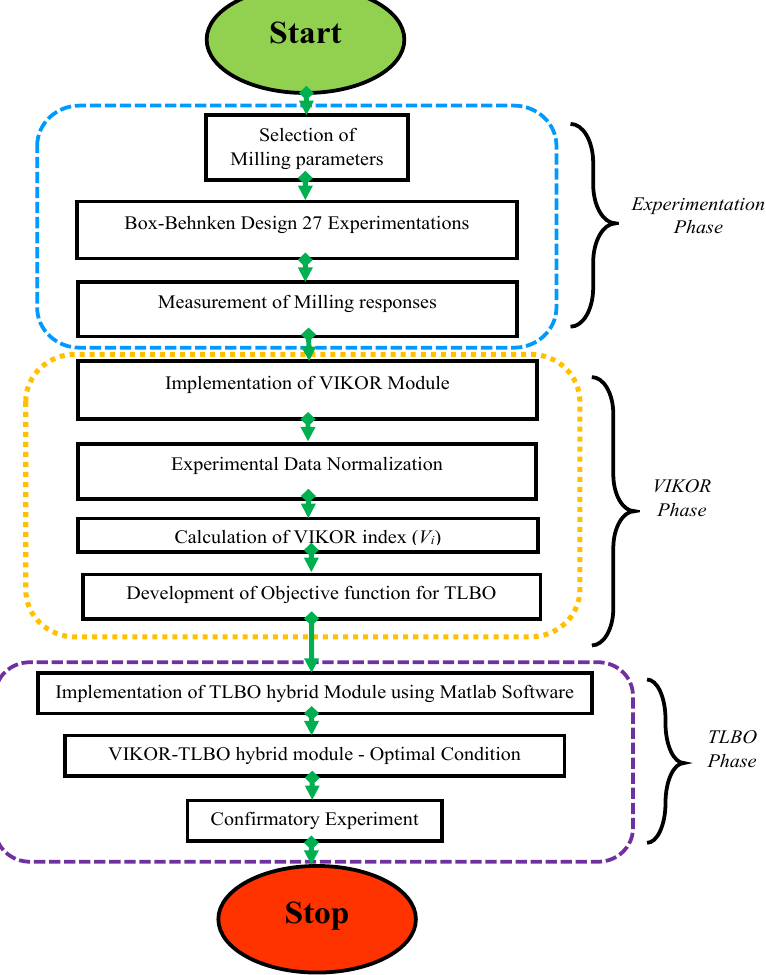
Fig. 5. Flowchart for VIKOR-TLBO hybrid